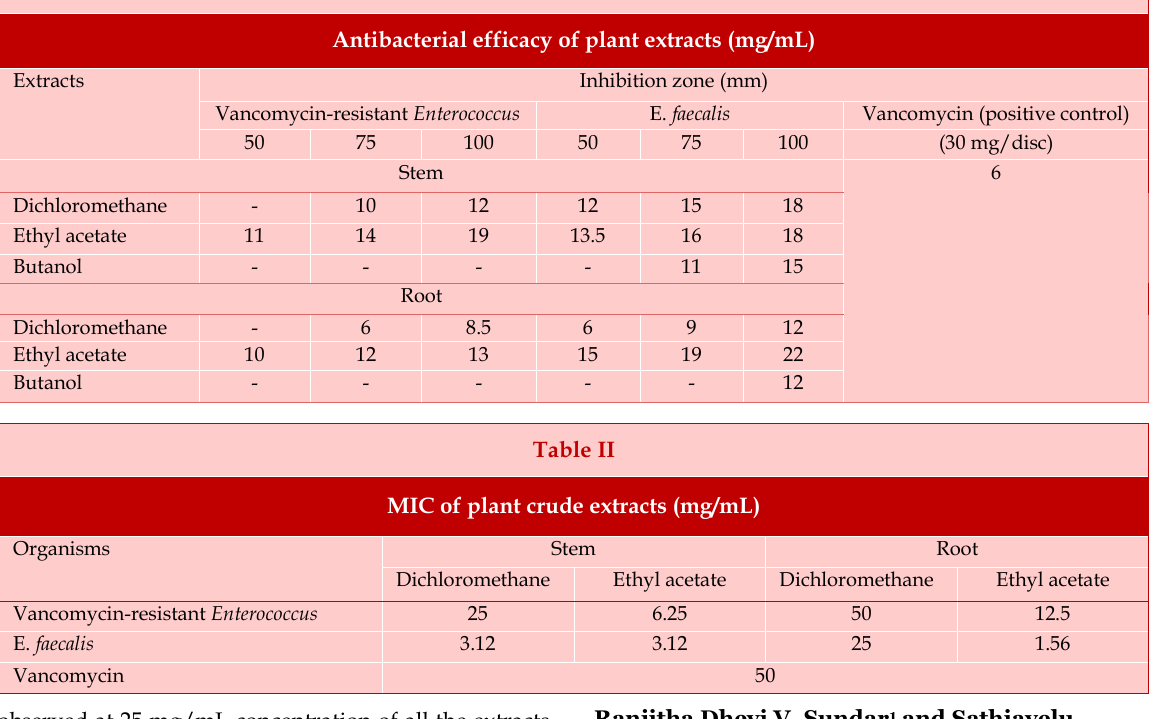
Antibacterial efficacy of plant extracts (mg/mL)